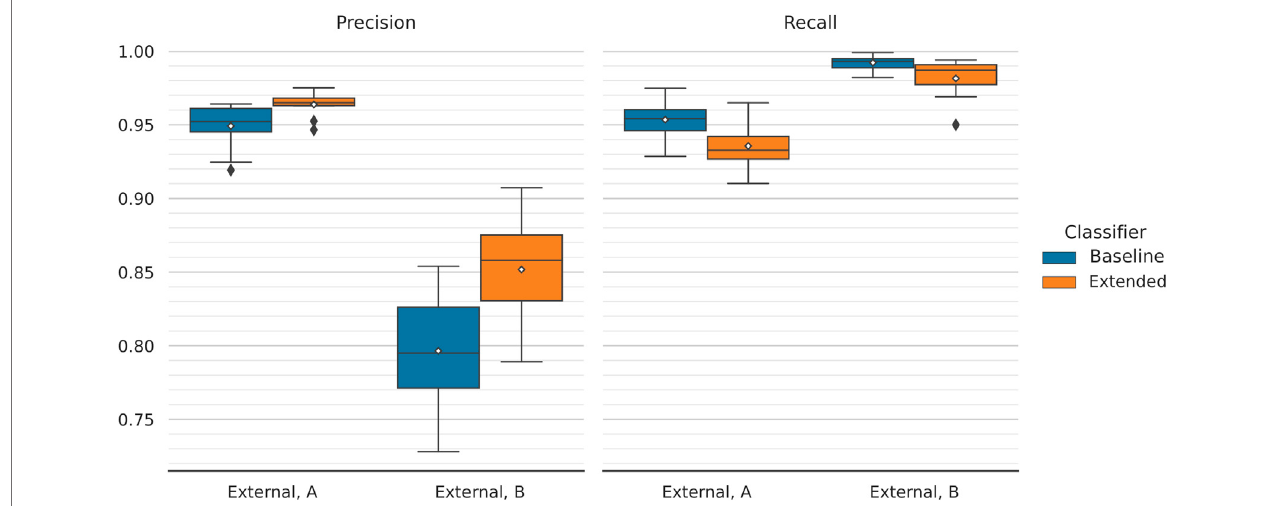
FIGURE 6 | Comparison of precision and recall scores between the two models during external validation. Classi fi cation performance is reported across 10 folds and mean values are annotated with white diamonds. Overall, moving from the fi rst to the second external dataset results in signi fi cantly decreased precision and moderately improved recall (with the latter approaching unity). No notable performance difference is observed between the models, with the exception of precision achieved on the second validation dataset (assessing generalisability). There, the extended model gets a higher score of 85.17 ± 3.63% compared to 79.66 ± 4.20% of its baseline counterpart. On the same data, extended and baseline models achieve recall scores of 98.15 ± 1.37% and 99.22 ± 0.51%,